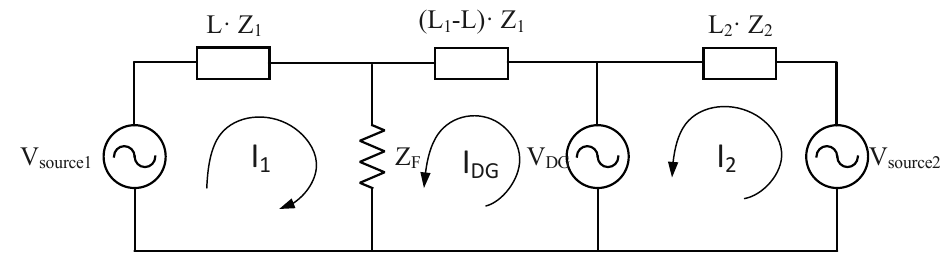
Figure 3. Simplified equivalent circuit.